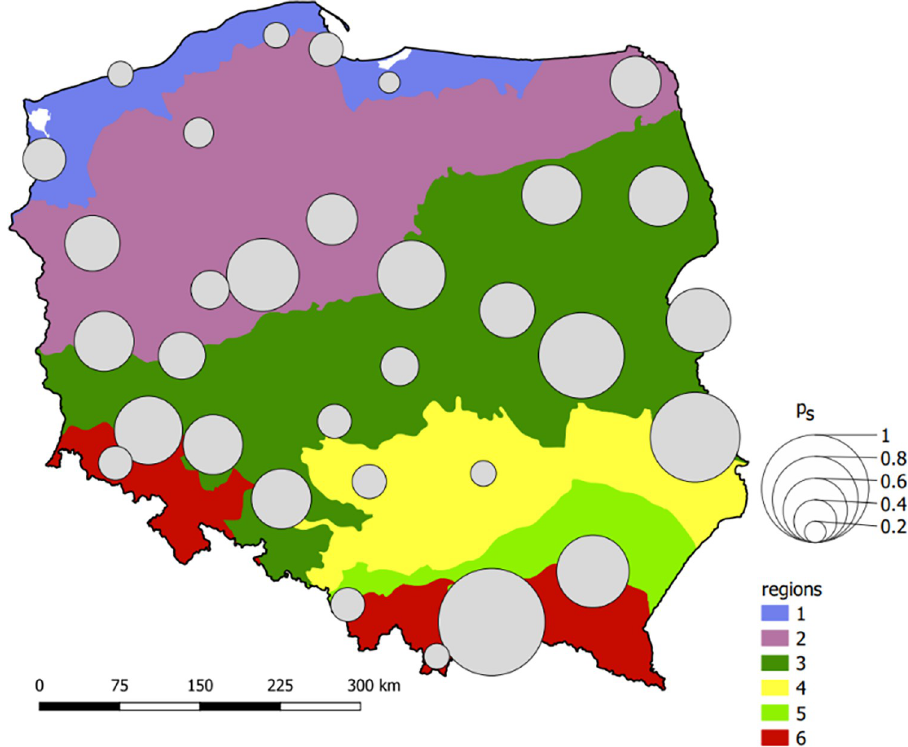
Fig 7. Variability in the stormwater flooding sensitivity index (p s ) in Poland for selected cities and regions (region names are listed in Fig 1).